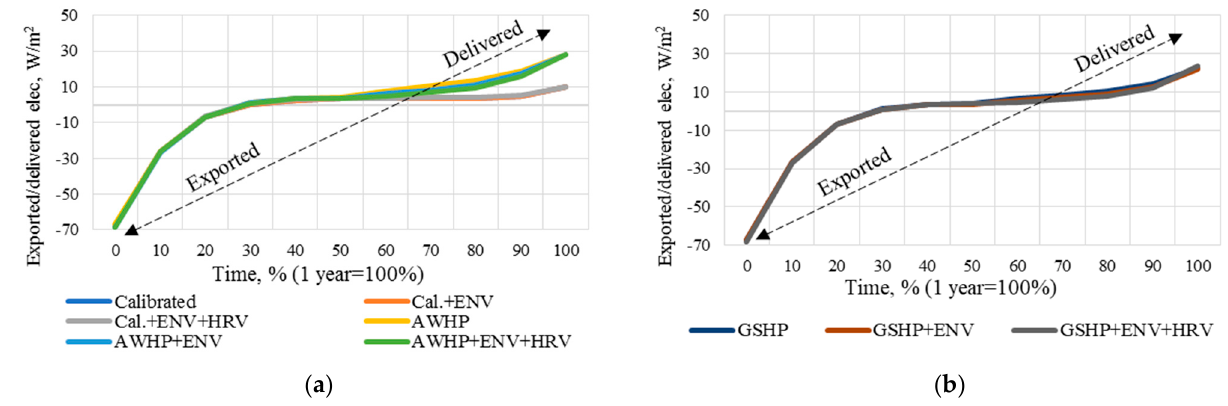
Figure 7. Exported/delivered electricity unit load from PV for ( a ) general and AWHP cases and ( b ) GSHP cases.